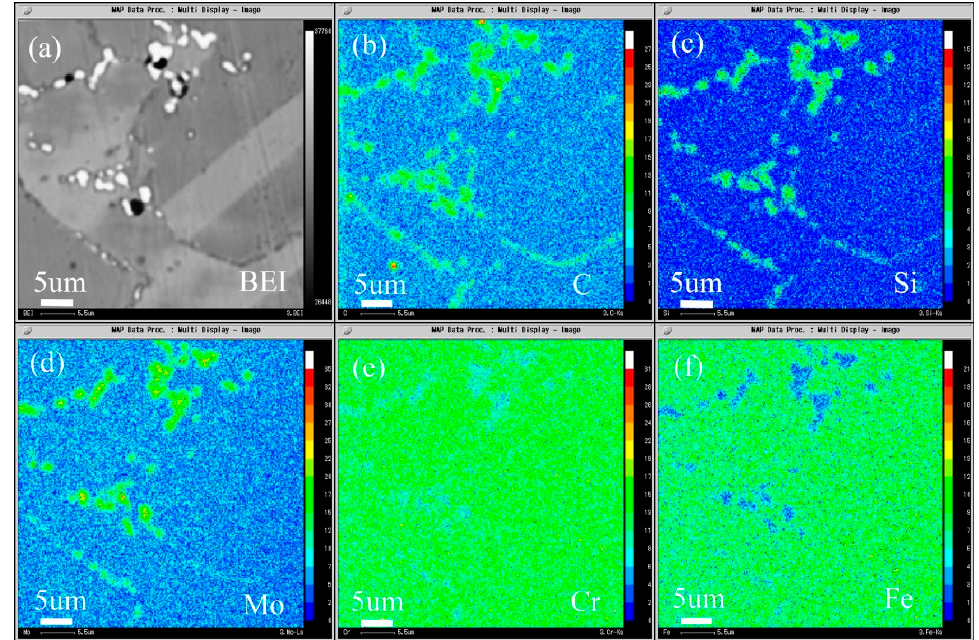
Figure 19. Microstructure of the 0.045C specimen aged at 900 °C for 2 h: ( a ) BEI image and the area distribution of ( b ) C, ( c ) Si, ( d ) Mo, ( e ) Cr, and ( f ) Fe by EPMA.